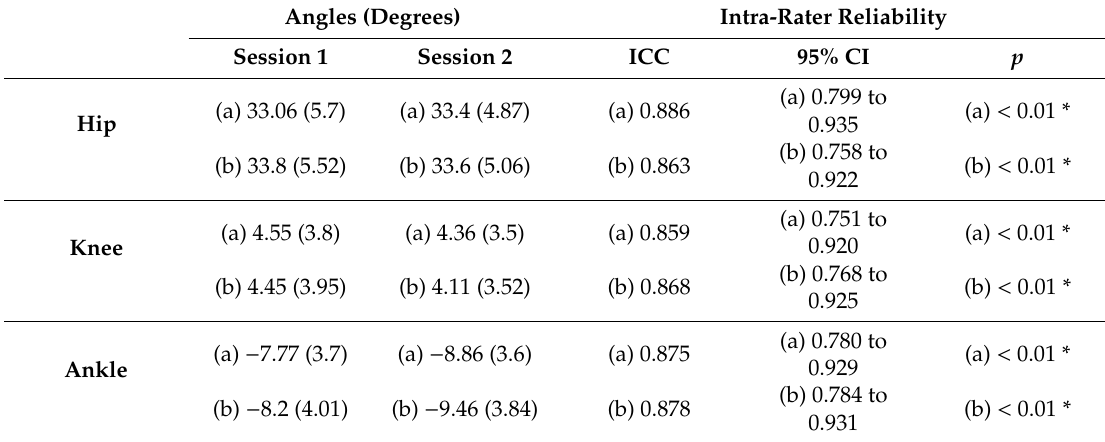
Table 1. Intra-rater reliability of the Kinovea